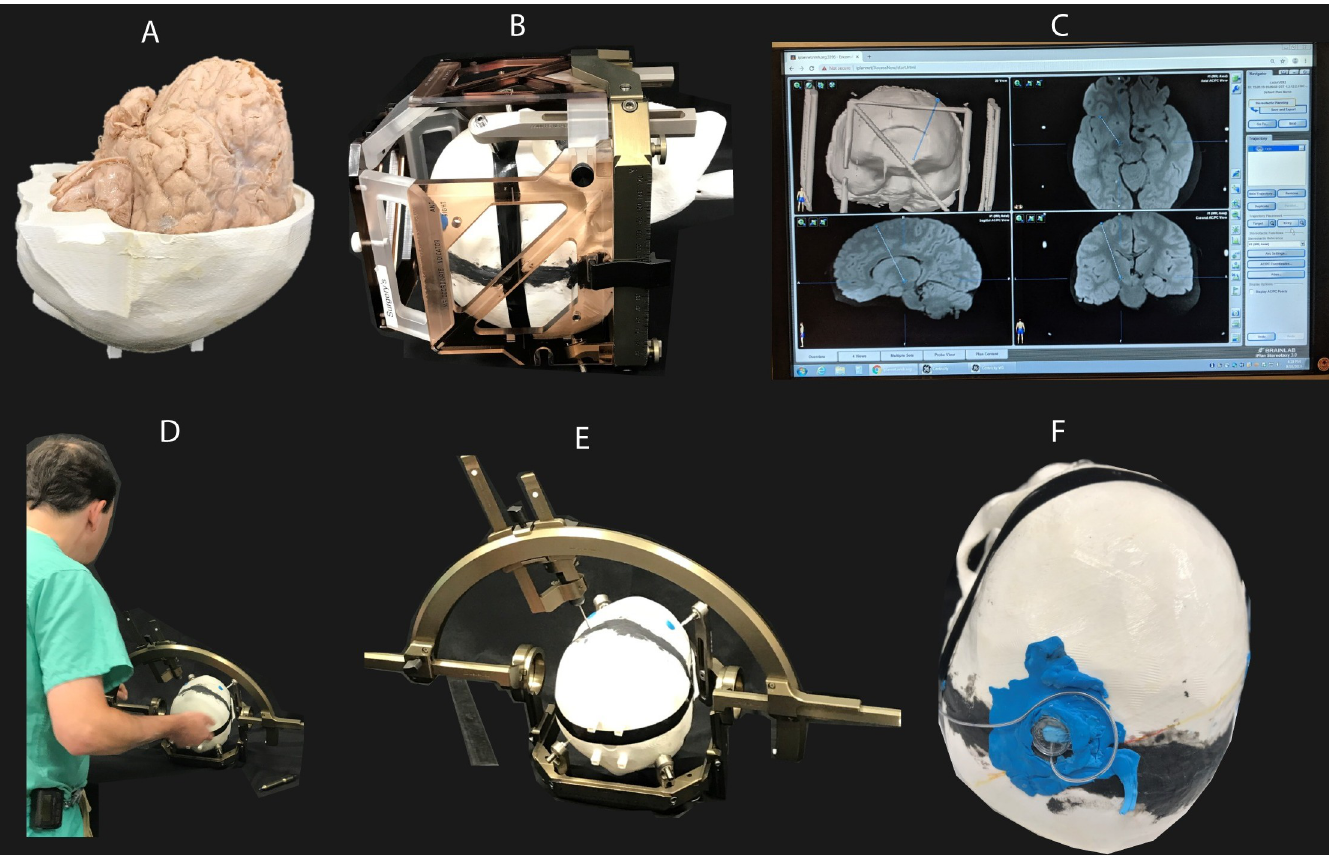
Fig 5. Steps of implanting DBS lead into a cadaver brain. (A) A formalin-fixed cadaveric brain was contained inside a 3D printed skull structure which was then filled with formalin solution. (B) The skull was attached to a Lakesell model G base ring (Elekta, Stockholm, Sweden) using titanium fixation pins, placed inside MRI fiducial box, and scanned at 1.5T for localizing subthalamic nucleus. (C) Images from MRI scan were transferred to BrainLAB iPlan server for determining coordinates of subthalamic nucleus as well as the entry point of the DBS lead on the skull. (D-F) A StimLoc ring was attached to the skull for the electrode implantation. After implanting the DBS lead, the StimLock ring was removed and a burr hole cover was placed to fixate the lead at the entry